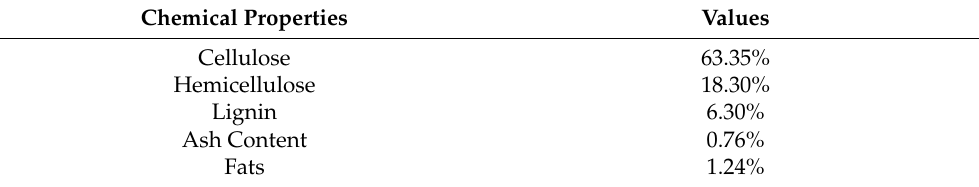
Table 3. Fiber Chemical composition.